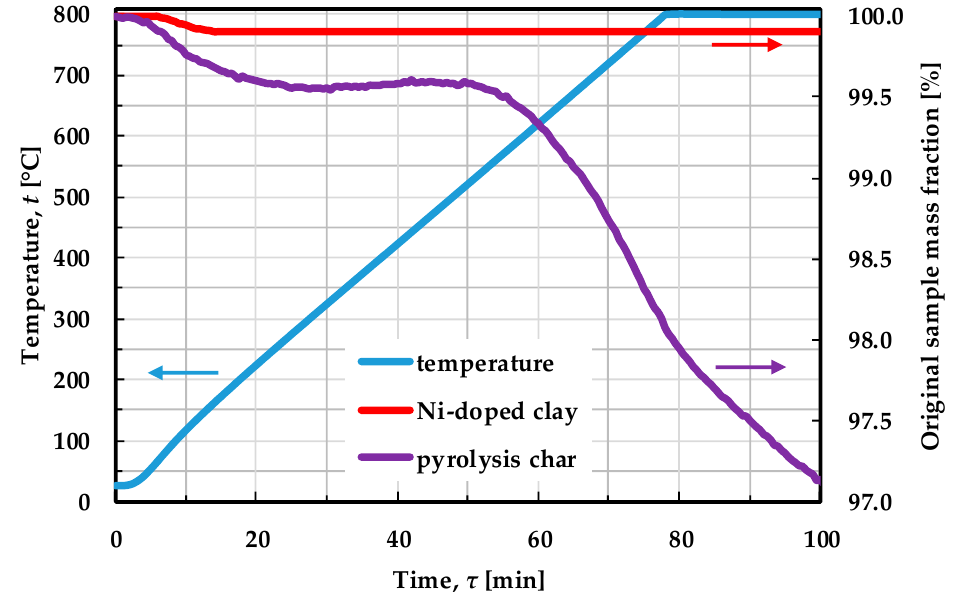
Figure 1. TG analysis of Ni-doped (3 mass%) clay mineral calcined at 800 °C (red line) and tire pyrolysis char activated at 800 °C (violet line) catalysts in nitrogen stream.